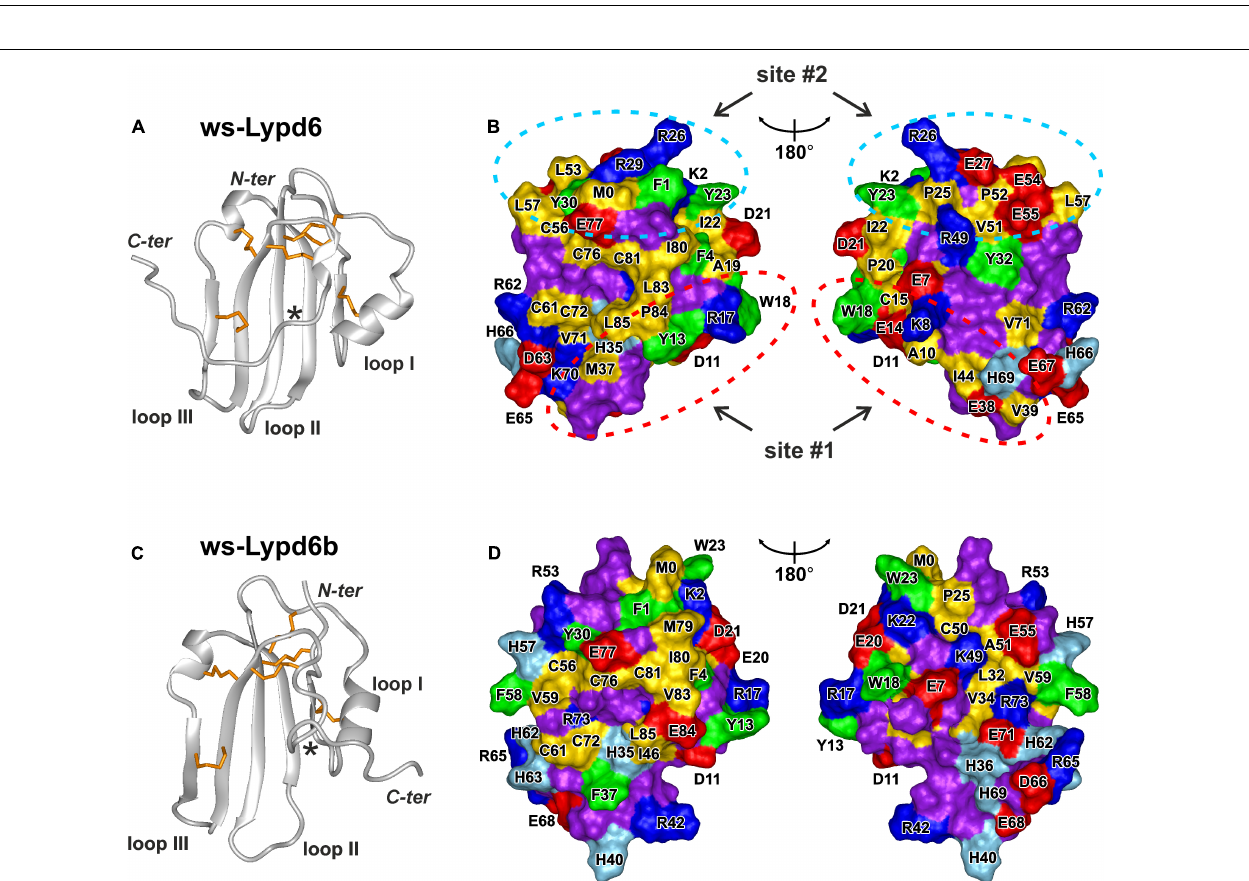
FIGURE 7 | Spatial structures and molecular surfaces of ws-Lypd6 (A,B) and Lypd6b (C,D) . (A,C) The disulfide bonds are in orange. Only one conformation of the flexible C -terminal “tail” is shown for each protein. The C -termini of the structured LU-domains (Leu85) are marked with asterisks. (B,D) Two-sided view of the molecular surfaces. Only LU-domains without C -tails (terminated at Leu85) are shown. The hydrophobic (Ala, Met, Ile, Leu, Val, Cys, and Pro), aromatic (Phe, Trp, Tyr), polar (Asn, Gln, Gly, Ser, and Thr), positively charged (Arg and Lys), negatively charged (Asp and Glu), and His residues are colored in yellow, green, violet, blue, red, and cyan, respectively. Two possible receptor-binding sites responsible for the Lypd6 interaction with nAChRs are highlighted by dashed ellipses. Orientation of the molecular surfaces in the left parts of the panels (B,D) is identical to the molecules orientation in (A,C) PDB codes: ws-Lypd6—6IB6, ws-Lypd6B—6ZSO (Paramonov et al.,